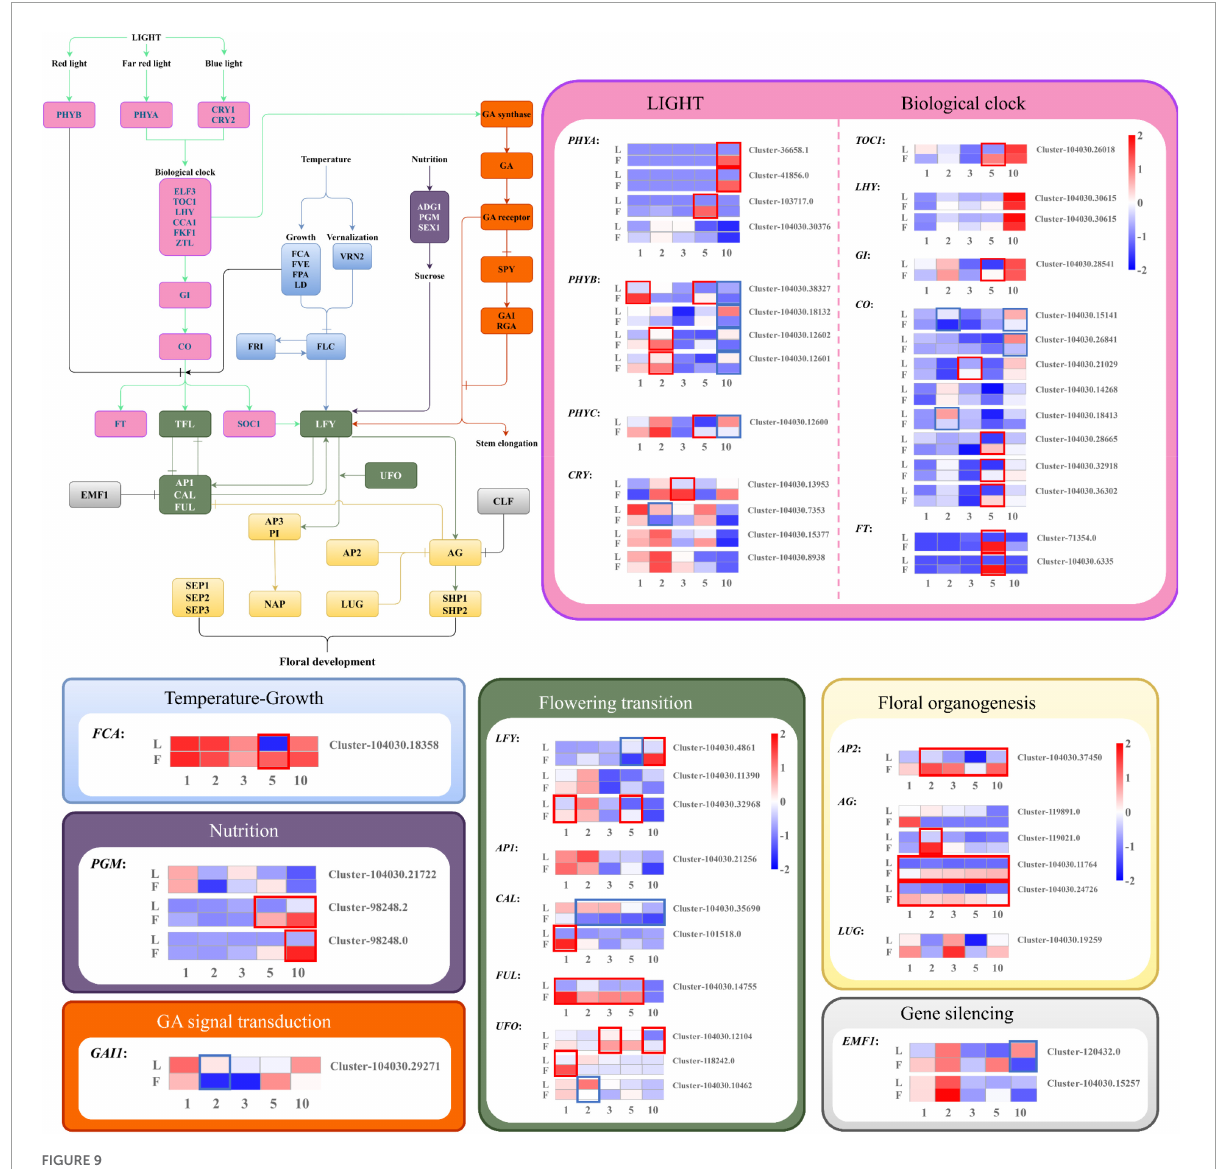
FIGURE9 Differentially expressed flowering Dacrydium pectinatum unigenes identified in comparisons between leaf and female cone tissues. The gradient-colored barcode at the top right indicates the log 2 (FC) value. Fold change is calculated based on the difference multiple of fragments per kilobase of transcript per million mapped reads (FPKM) in different periods. The unigenes expression in female cone was significantly higher than leaves, which was framed in red box, and lower was in blue box. 1, 2, 3, 5, and 10: January, February, March, May, and October 2019; L, leaves; F, female cones. PHYA/B, Phytochrome A/B; CRY1/2, Cryptochrome 1/2; ELF3, Early flowering 3; TOC1, Timing of CAB1; LHY, Late elongated hypocotyl; CCA1, Circadian clock-associated 1; FKF1, Flavin-binding kelch repeat F-box 1; ZTL, Zeitlupe; GI, Gigantea; CO, Constans; FT, Flowering locus T; SOC1, Suppressor of constants overexpression 1; FCA, Flowering control local A; FVE: MSI1-homolog, (a conserved WD-repeat protein found in many chromatin complexes); FPA, RRM-domain proteins; LD, Luminidependens; VRN2, Vernalization 2; FLC, Flowering locus C; FRI, Frigida; ADG1, ADP glucose pyrophosphorylase; PGM, Phosphoglucomutase; SEX1, Starch excess 1; GA, gibberellin; SPY, Spindly; GAI, Gibberellic acid insensitive; RGA, Repressor of GA; TFL, Terminal flower 1; LFY, Leafy; AP1/2/3, Apetala 1/2/3; CAL, Cauliflower; FUL, Fruitfull; UFO, Unusual floral organs; EMF1, Embryonic flower 1; CLF, Curly leaf; PI, Pistillata; AG, Agamous; SEP1/2/3, Sepallata1/2/3; NAP, NAC-like activated by AP3/PI; LUG, Leunig; SHP1/2, Shatterproof